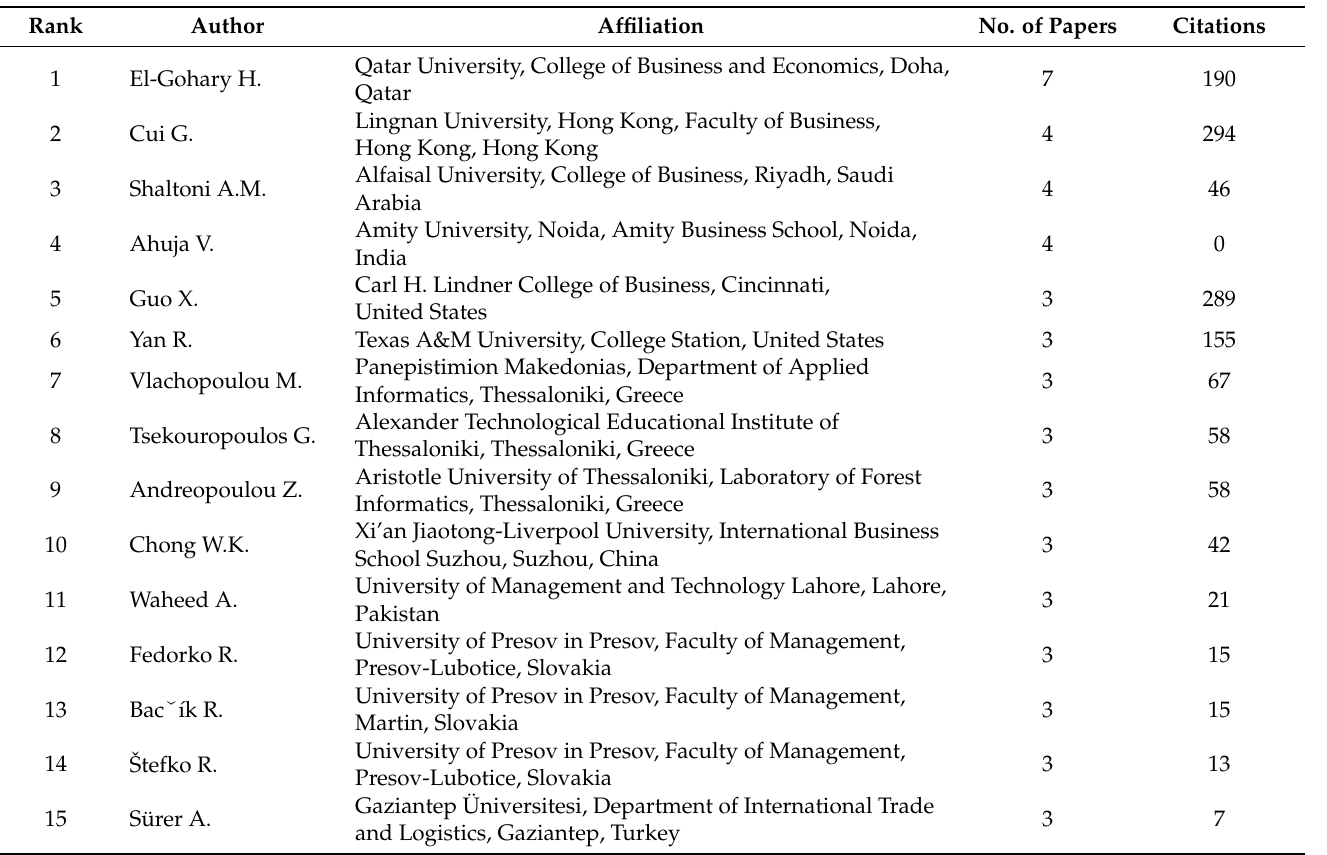
Table 6. The most productive authors in electronic